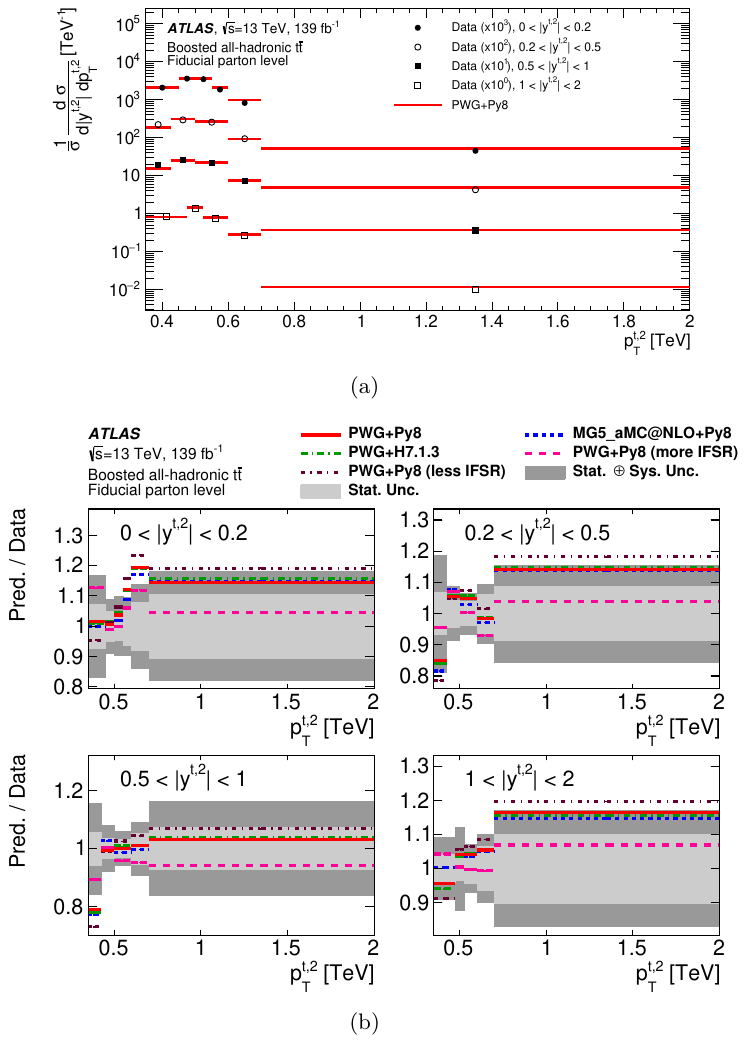
Figure 47 . (a) Normalized parton-level fiducial phase-space double-differential cross-sections as a function of the absolute value of the rapidity and transverse momentum of the second-leading top- quark, compared with the Powheg+Pythia 8 calculation. Data points are placed at the centre of each bin and the Powheg+Pythia 8 calculation is indicated by solid lines. The measurement and the prediction are normalized by the factors shown in parentheses to aid visibility. (b) The ratios of various MC calculations to the normalized parton-level fiducial phase-space differential cross-sections. The dark and light grey bands indicate the total uncertainty and the statistical uncertainty, respectively, of the data in each